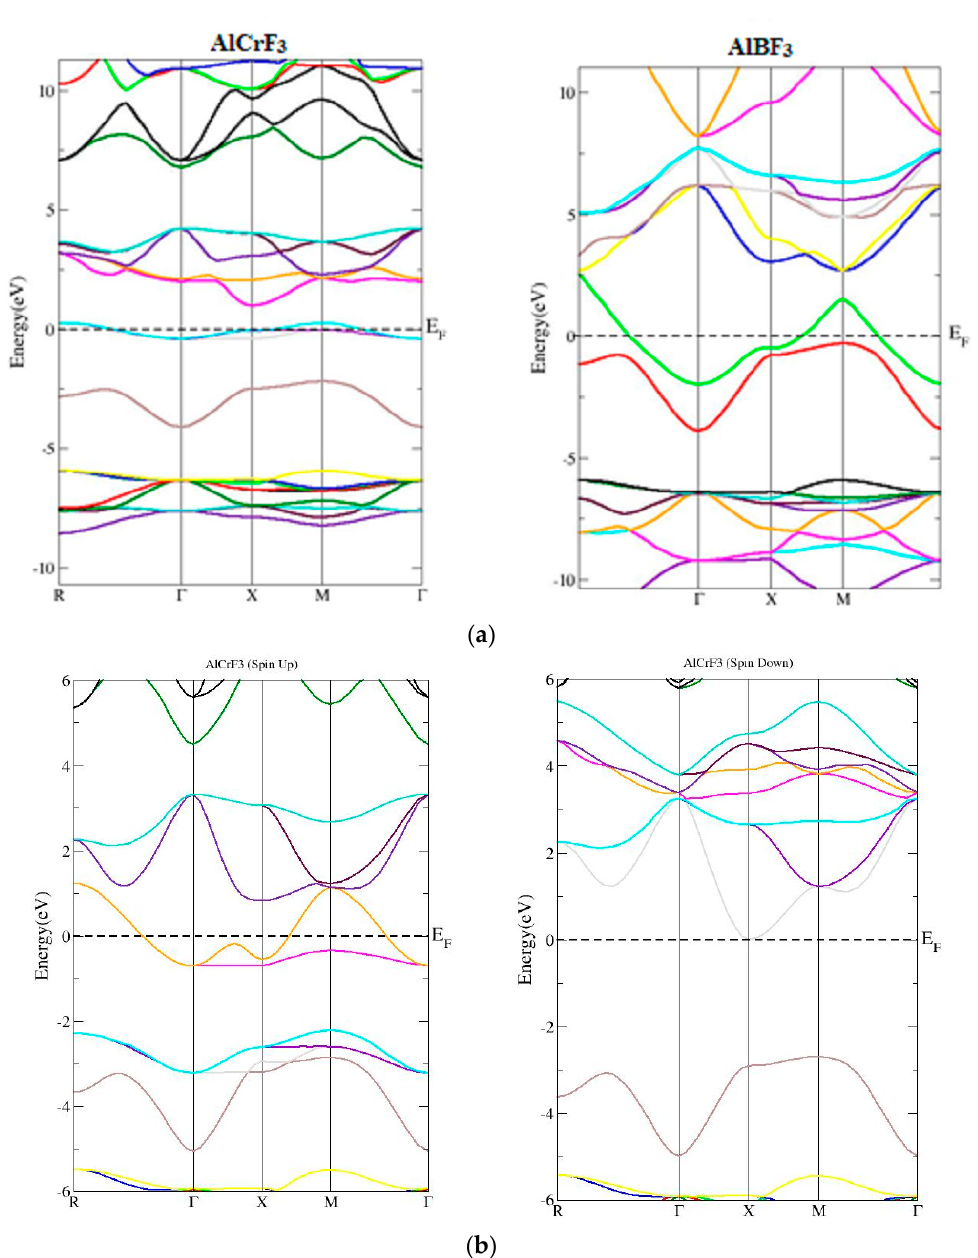
Figure 3. ( a ) Computed band structures of AlMF 3 (M= Cr, B) using TB ‐ MBJ. ( b ) Computed band structures of AlCrF 3 using GGA +